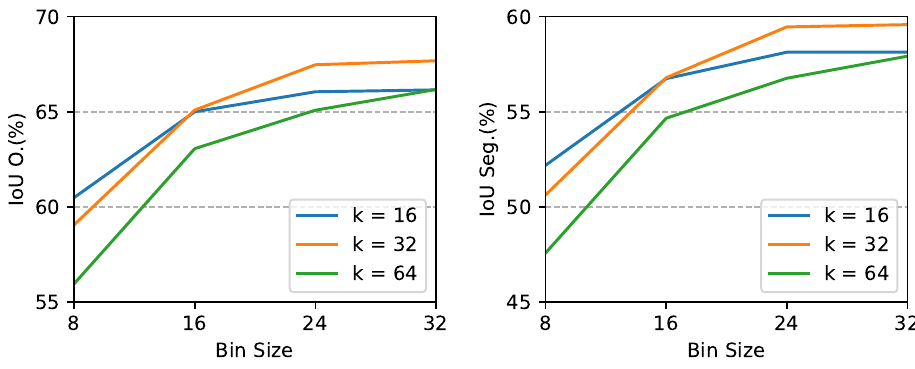
Figure A1. The curves of IoU O. vs. bin size ( left ) and IoU Seg. vs. bin size ( right ) when different neighbourhood sizes and bin sizes are used in our handcrafted feature. We use k to denote the neighbourhood size.